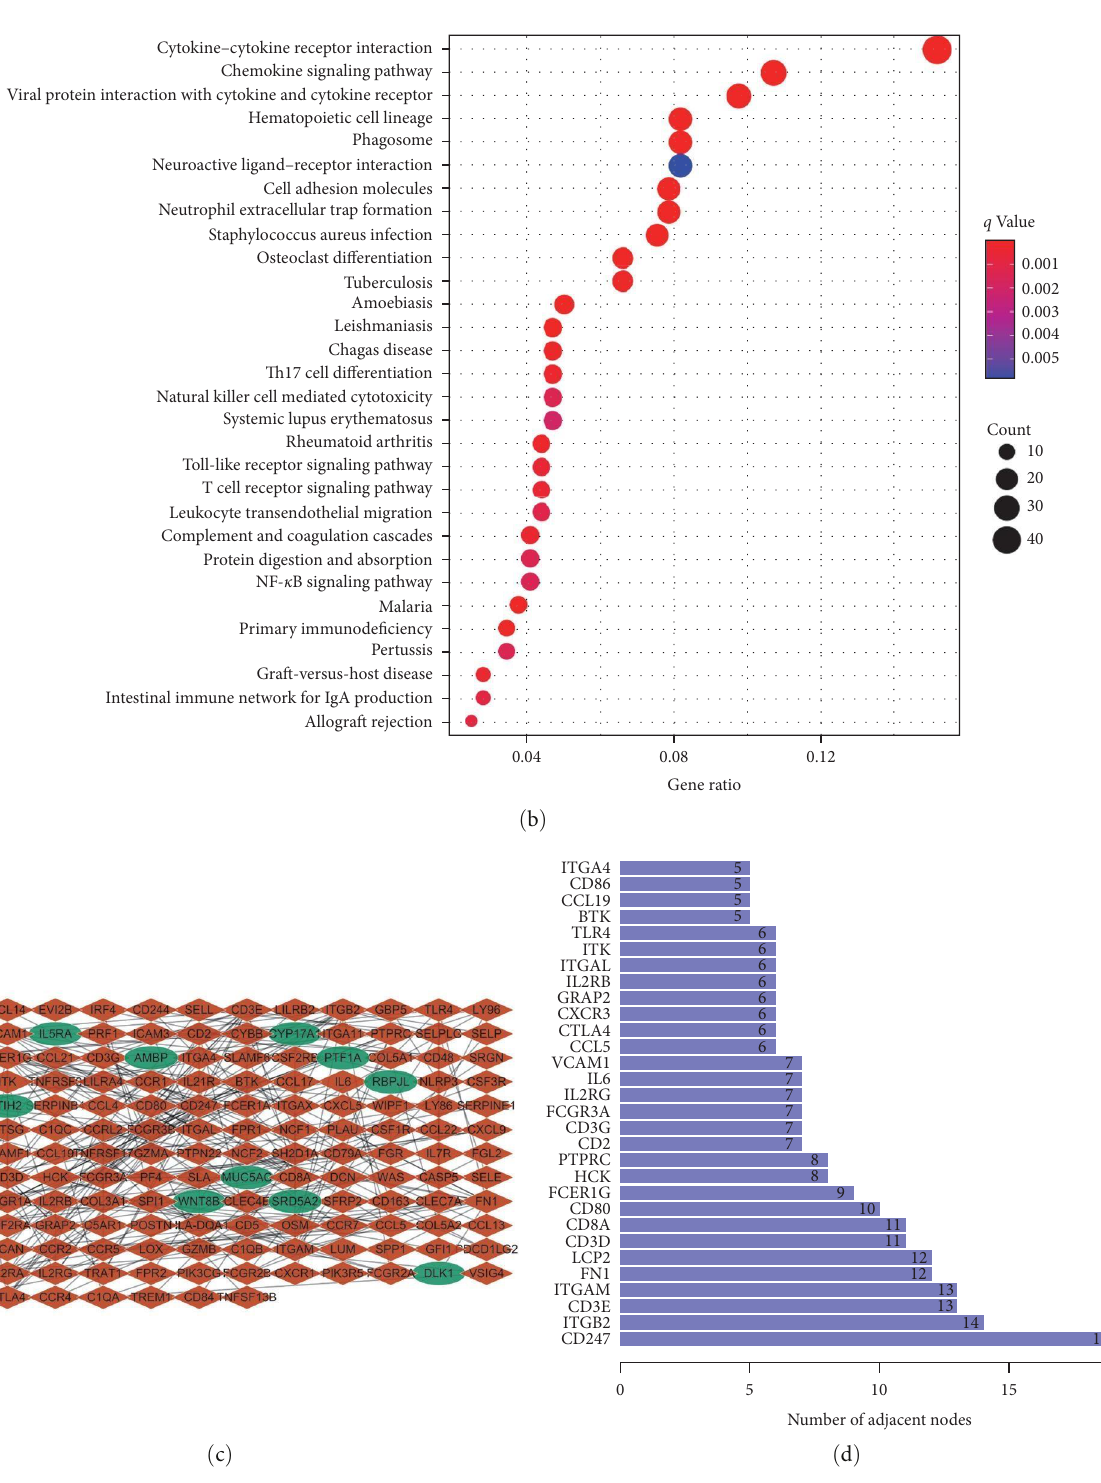
F IGURE 3: Functional enrichment analyses of DEGs. (a) GO enrichment analysis. (b) KEGG enrichment analysis. (c) Protein – protein interaction network. Brown: upregulation; Green: downregulation. (d) The top 30 genes ordered by the degree of nodes in PPI